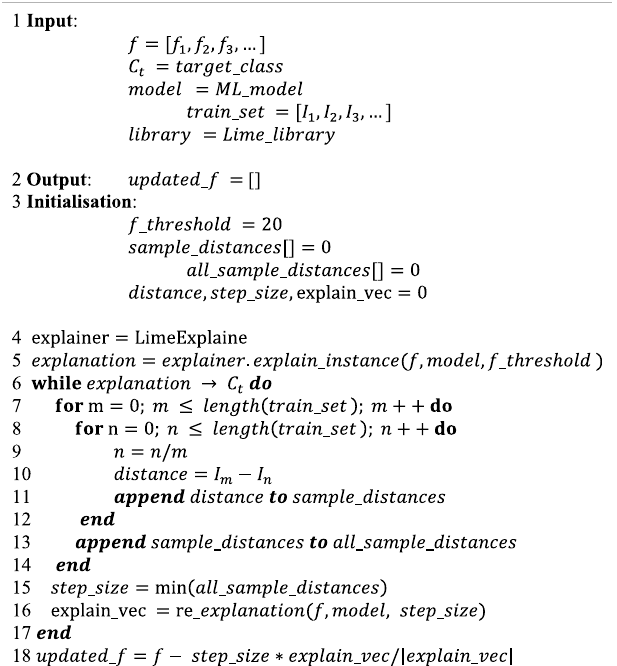
Algorithm 2 | Factor Identi fi cation Using Explainable ML